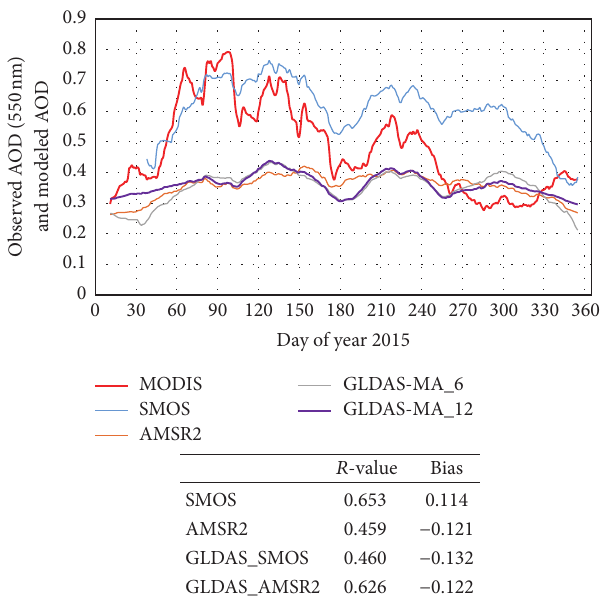
Figure 6: 11-day moving average of observed and modeled AOD in different season of the year 2015 with statistical table of correlation coefficient and bias values of AOD model with observed AOD from